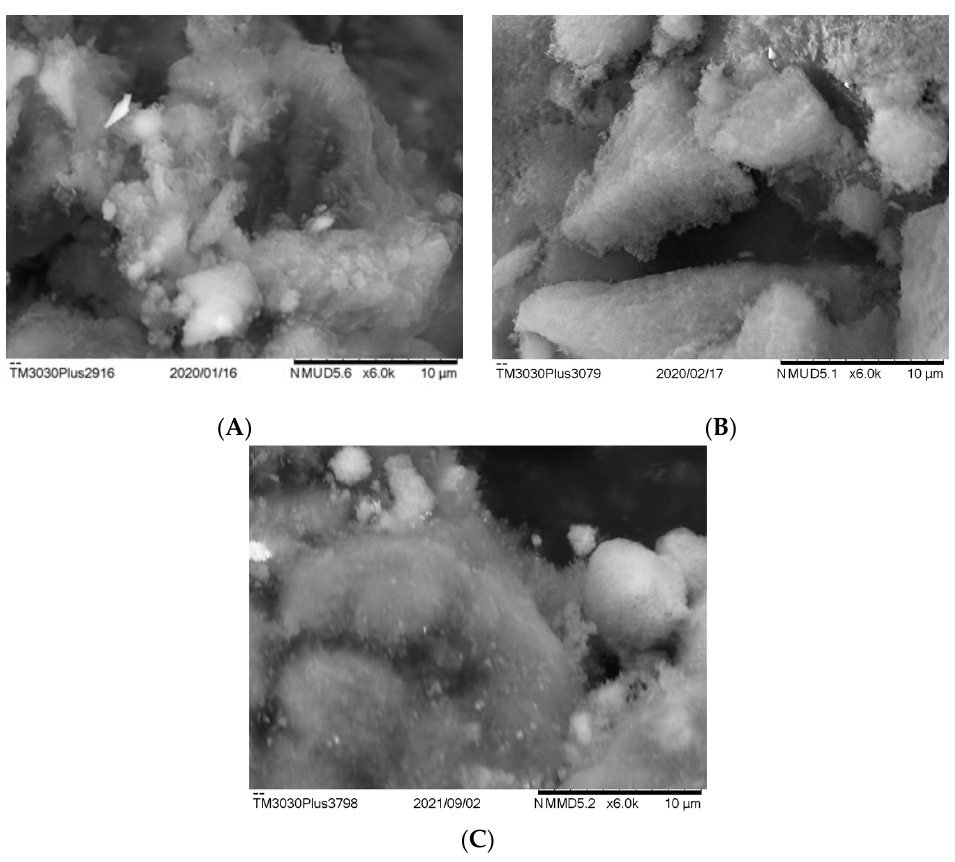
Figure 9. Micrographs of spent catalysts: NiAl ( A ), NiCeAl ( B ), and NiLaAl ( C ) with magnification of 6000×.